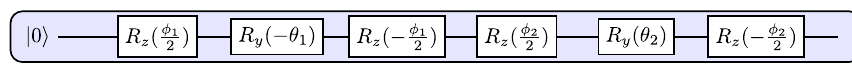
Fig. 1 Sketch of the quantum circuit for estimating the inner product: Circuit to estimate the inner product of two-dimensional vectors contains six rotational gates. Additionally, we also need a memory to store the information of this group, which could be represented by θ m , φ m , and an integer N , which represents the total number of data in this